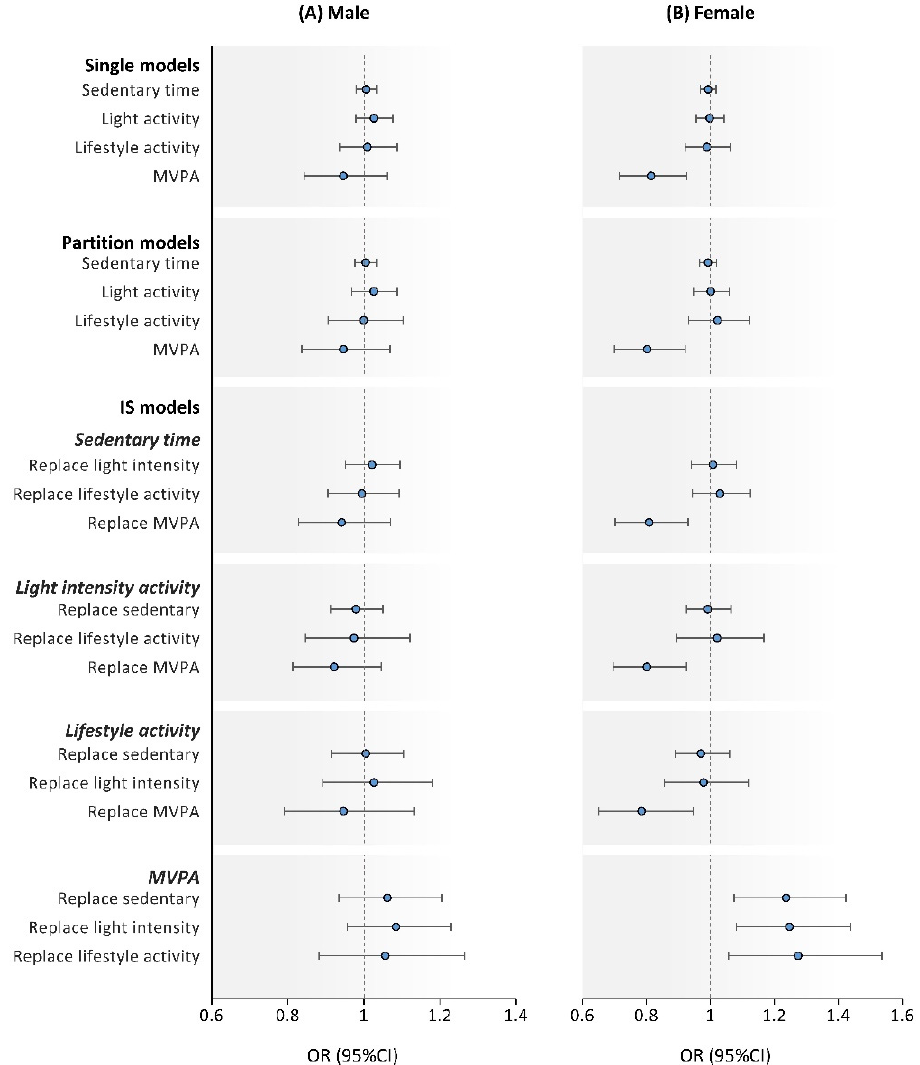
Figure 1. Single factor, partition, and isotemporal substitution models examining the association of sedentary behavior, light and lifestyle, and MVPA with adverse cardiometabolic health ( ≥ 3 risk factors) by male ( A ) and female ( B ). Note: Values were odds ratio (95%CI); each models including variables used models in Tables 3 and 4. MVPA, moderate-to-vigorous physical activity; OR, odds ratio; CI, confidence interval; IS model, isotemporal substitution model.